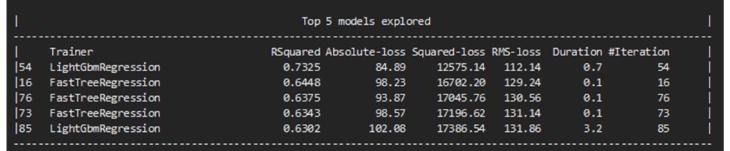
Figure 2. Training results for the flow from Greece to